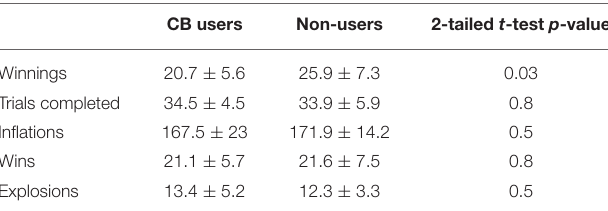
TABLE 2 | Behavioral